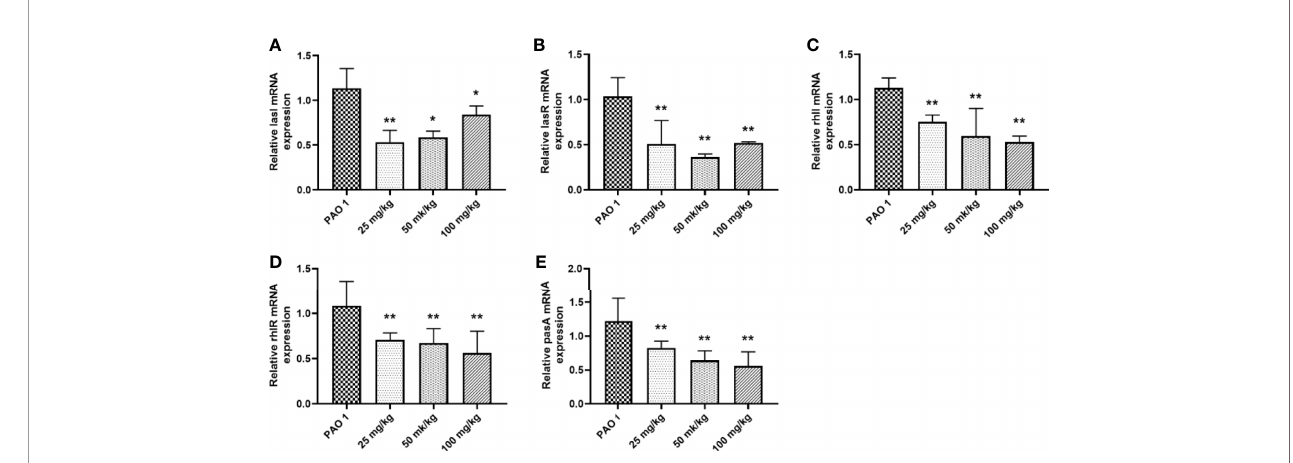
FIGURE 13 | Paeonol inhibited the mRNA expression of QS genes in the lung. (A) lasI, (B) lasR, (C) rhlI, (D) rhlR, (E) pqsA. All data were expressed as means ± SD (n=3). * P < 0.05 or ** P < 0.01 vs PAO1